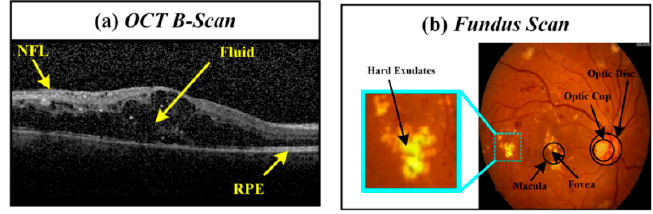
Figure 2. Appearance of macular edema symptoms in ( a ) an OCT B-scan and ( b ) fundus scan.